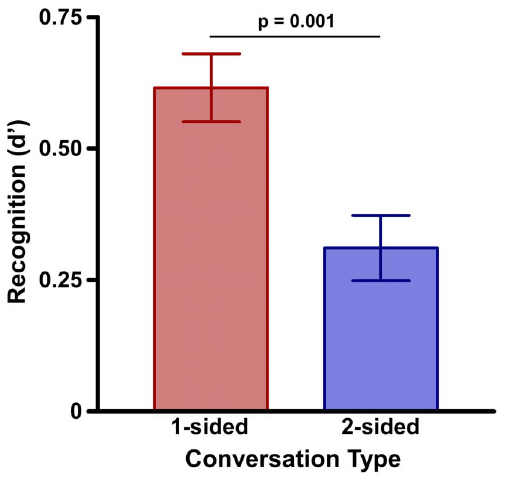
Figure 3. Average number of correct and incorrect anagram responses by gender. The average number of easy and hard anagrams that males and females answered correctly, regardless of which conversation they overheard.